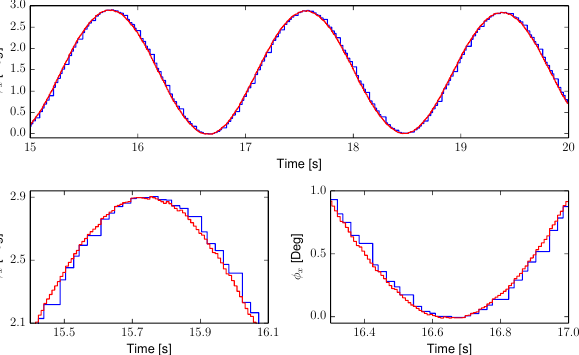
Figure 5: The figure shows the discrete-time state esti- mate of φ x (in blue), which is updated at the camera rate, and the predicted state (in red), which is in the faster robot rate of 125